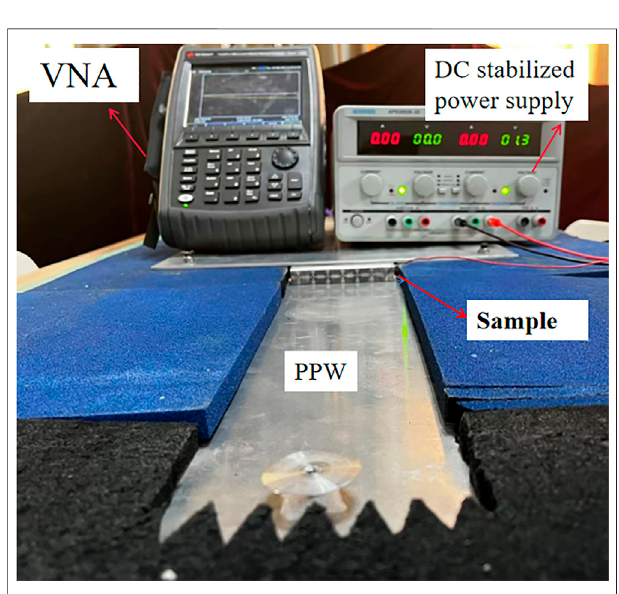
FIGURE 11 | Experiment system con fi gurable for the